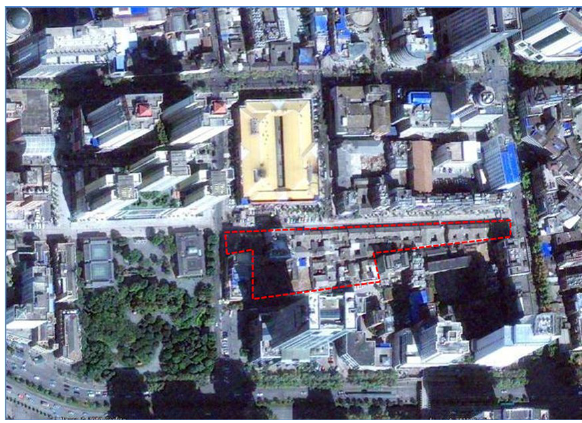
Figure 2. Nanqiang Street, present day